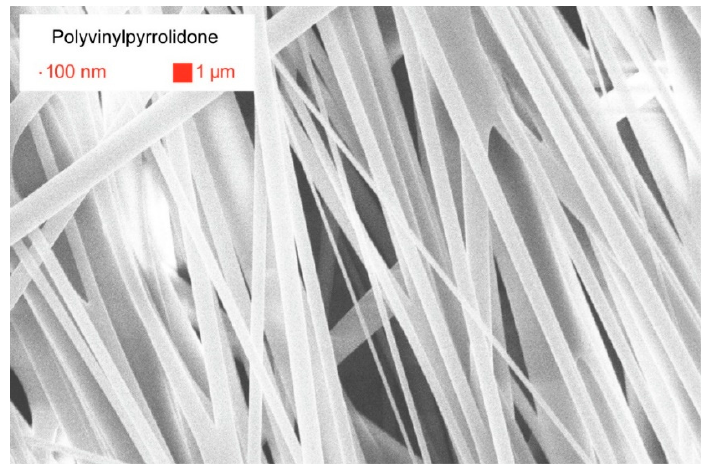
Figure A13. Polyvinylpyrrolidone fibers produced from our device. Median diameter of fibers from this sample was 833 nm.